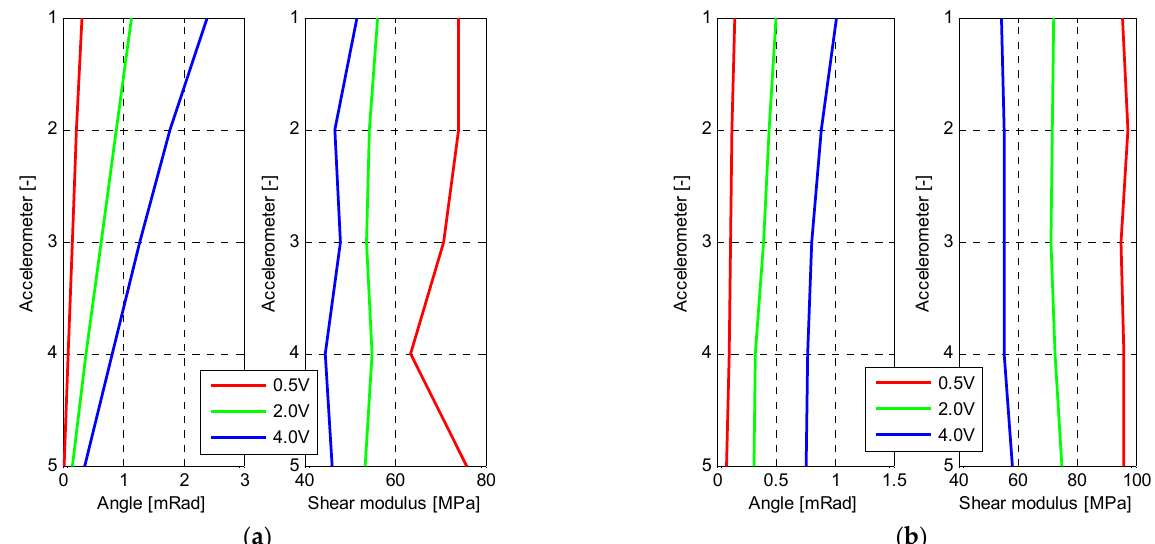
Figure 28. The shear modulus and maximum angle of rotation along the height of the soil sample (isotropic pressure 50 kPa): ( a ) Material: Sa 3; ( b ) Material: saclSi 1.